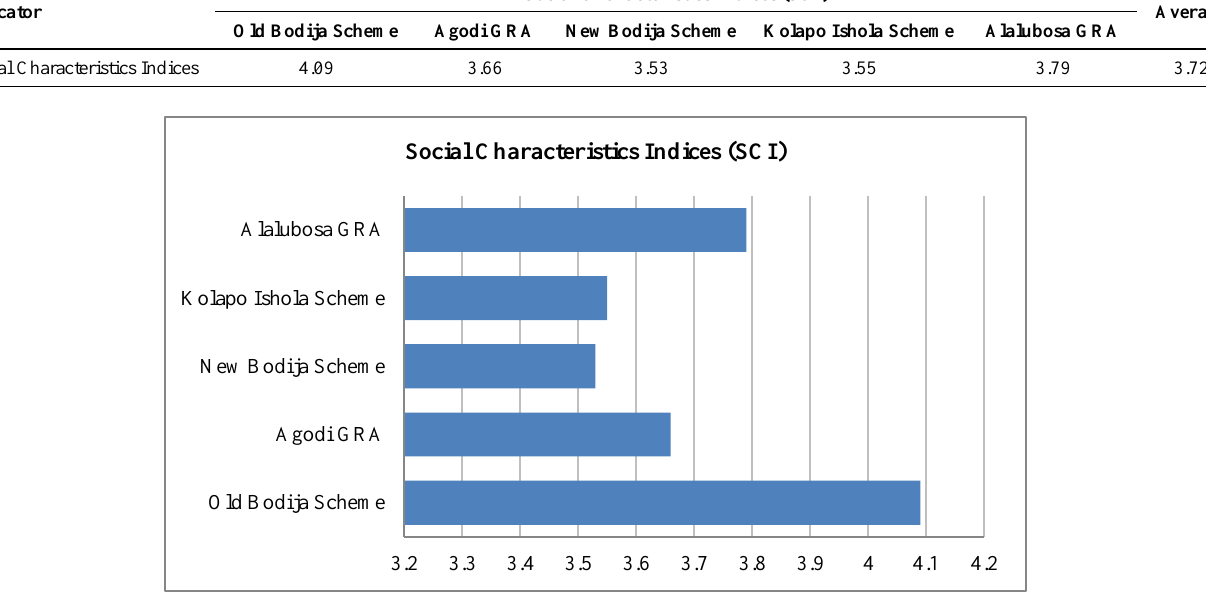
Figure 8. The comparative means of the Social Characteristics Indices in the five study areas